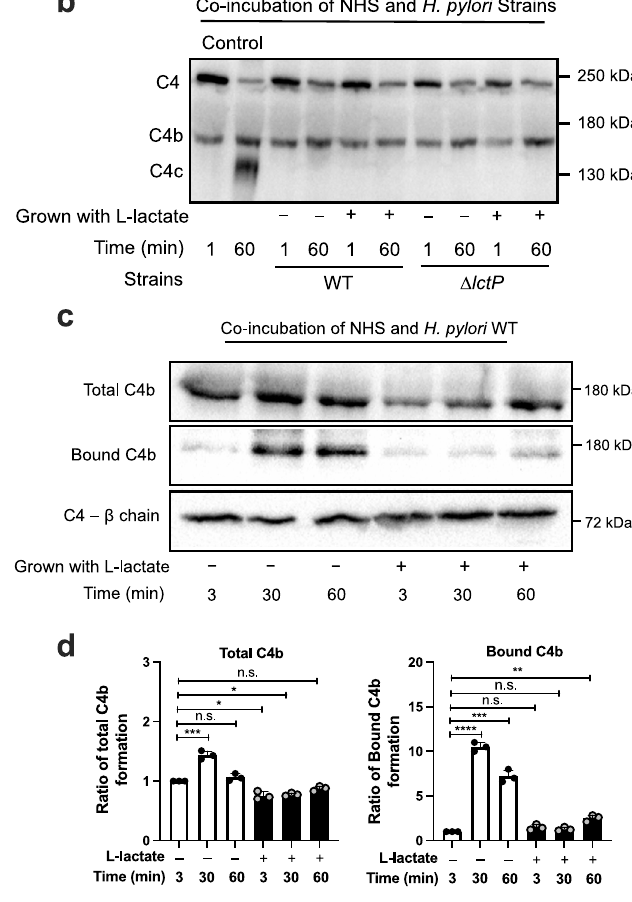
Fig. 4 | L-lactate mediates destabilization of C4b binding to H. pylori . a SchematicdiagramofC4primaryactivationandsecondarydegradation,adapted from 35 . b Western blot of C4 protein and products after activation in the presence ofWTand Δ lctPH.pylori over60min,usingnon-reducinggels.Apositivecontrolof complement activation and C4c formation was triggered by heated human IgG. Positions of C4, C4b, and C4c are shown at the left, and molecular weight is indi- cated on the right. The result is representative of three independent experiments with triplicate biological samples. c H. pylori PMSS1 WT was grown ± L-lactate and then treated by 10%NHS forthe indicated time periods. Each samplewas split into three: (1) treated by sample buffer only (total C4b); (2) centrifuged at 3000 × g for 3min before adding sample buffer (bound C4b); (3) treated by sample buffer plus